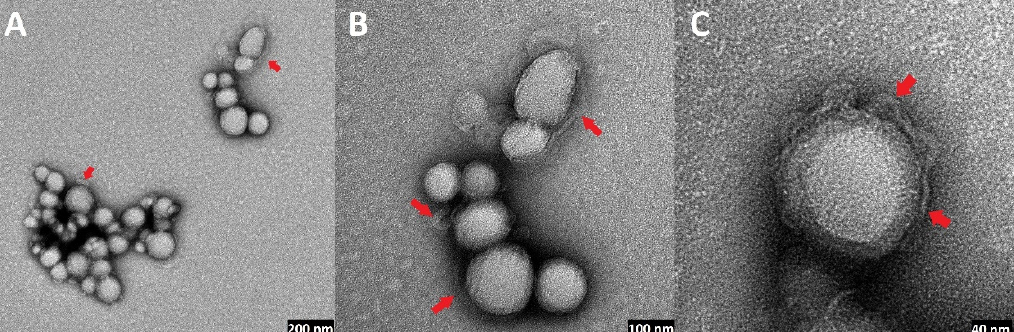
Figure 11. TEM images of bare UA-loaded PLGA nanoparticles: ( A ): magnitude 40 k, scale bar 200 nm; ( B ): magnitude 80 k, scale bar 100 nm; ( C ): magnitude 200 k, scale bar 40 nm.